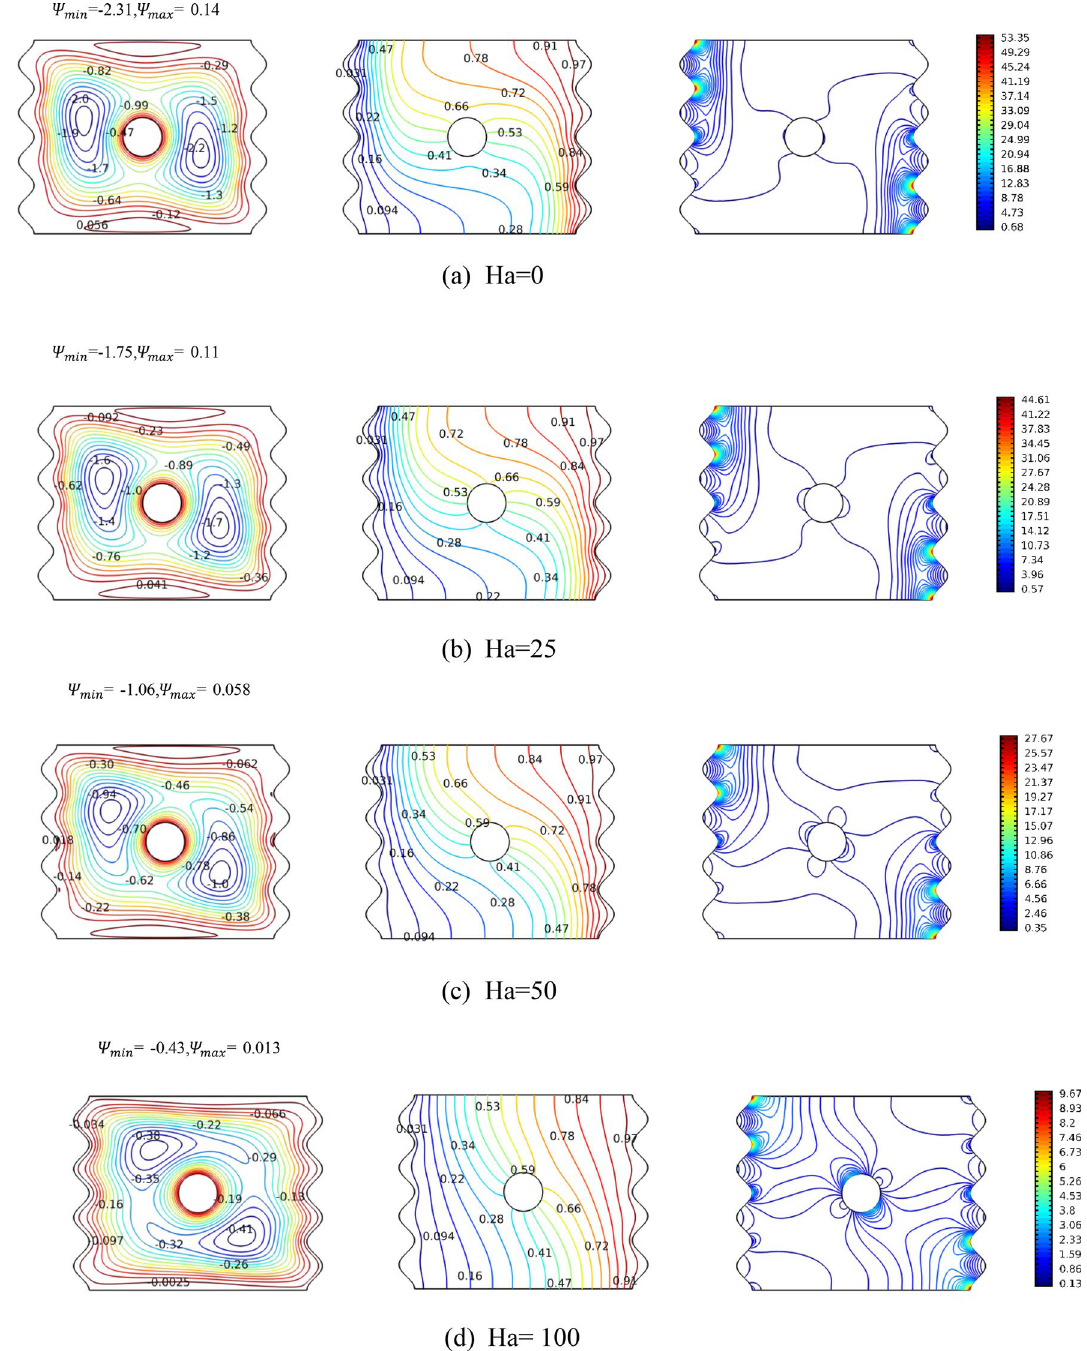
Figure 5. Streamlines, isotherms and isentropic variation by Hartman number Ha for case, φ = 0.04, Ra = 10 4 , Ω = 0. The panels represent the levels of the